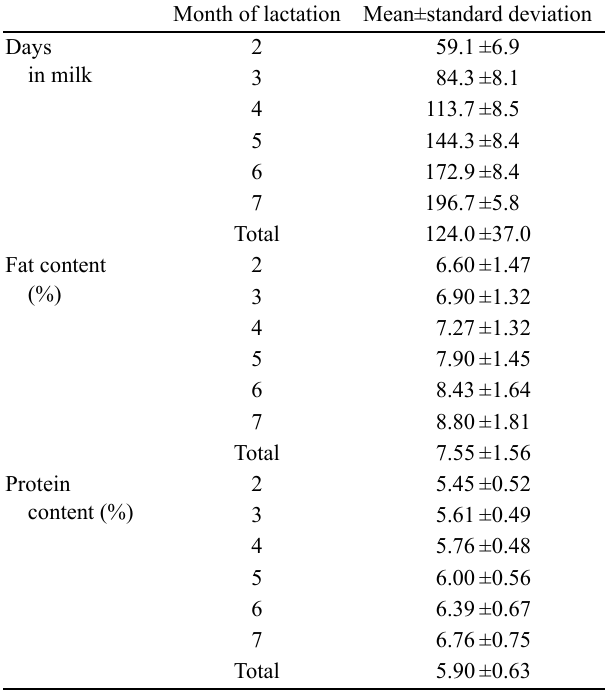
Table 1. Basic statistics for fat and protein content (by month of